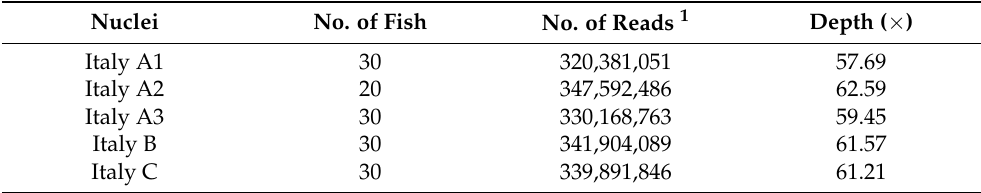
Table 1. Nuclei from the same hatchery investigated in this study, the number of fish used to constitute the DNA-pools, the overall number of high-quality reads utilised for the alignment, and depth of sequencing considering the alignment to the gilthead seabream reference genome. Nuclei No. of Fish No. of Reads 1 Depth ( × ) Italy